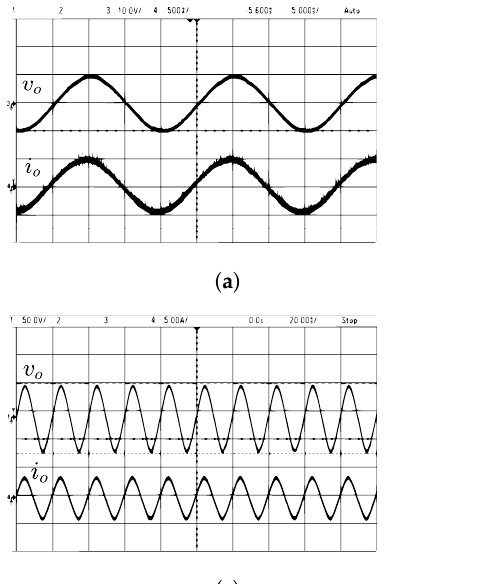
Figure 21. Experimental results under steady state ( a ) top trace: v ∗ (2 V/div), bottom trace: v c (2 V/div); ( b ) top trace: v (cid:48) (1 V/div), bottom trace: v c (cid:48) (2 V/div); ( c ) top trace: g 1 , g 2 (2 V/div), bottom trace: v c (cid:48) (1 V/div). The load voltage and current waveforms obtained during the experiment for different load conditions are given in Figure 22.